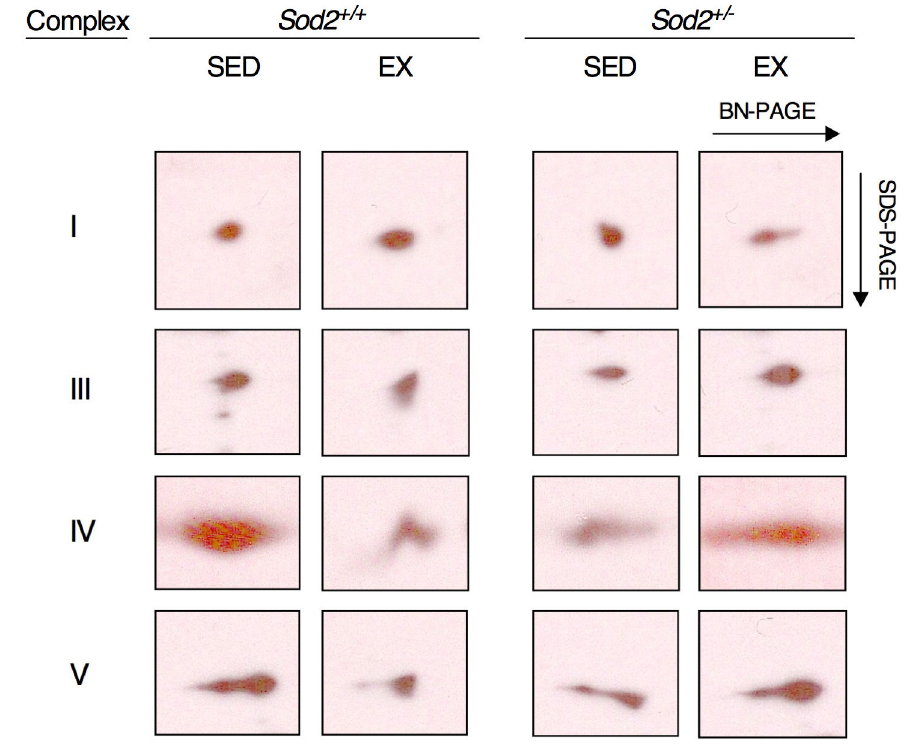
Figure 5. Mitochondrial complex assembly worsens in Sod2 +/- mice subjected to exercise. Lauryl-maltoside solubilized mitochondria were separated using two-dimensional Blue-Native PAGE in order to visualize native migration of each of four electron transport chain complexes. A lack of intermediate species in assembling the native complex is visualized as a shorter horizontal migration, while unassembled complexes are evident as tails or very broad bands. Note the divergent response to exercise between the two genotypes. Samples were run simultaneously on the same native gel. Image frames are identically sized for each complex and were acquired from the same film exposure. This experiment was repeated twice using different samples from each of the four groups in order to confirm that this was a reproducible